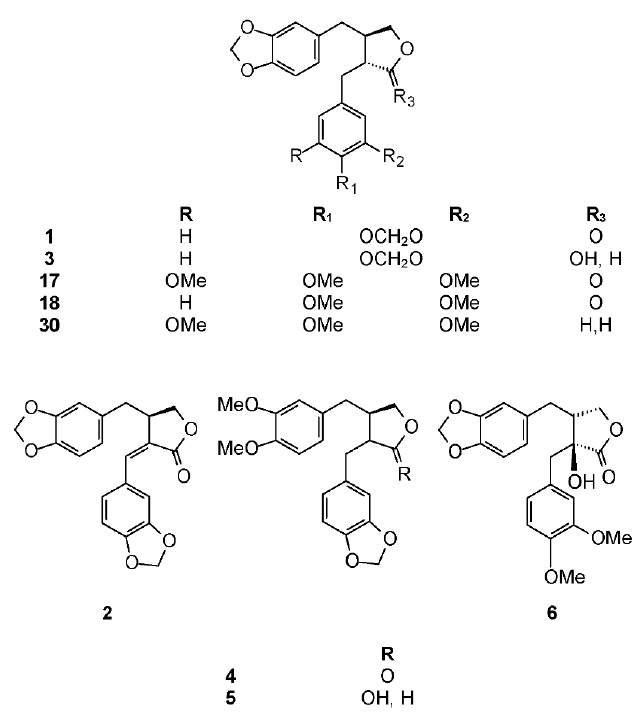
Figure 1. Structures of dibenzyl butyrolactone lignans isolated from Bursera spp.